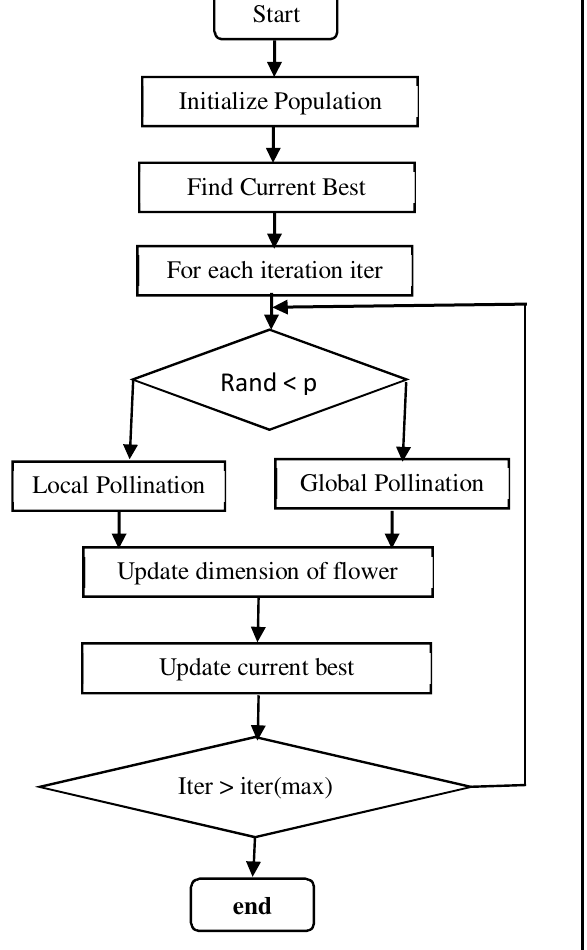
Fig. 4: Flower Pollination Algorithm